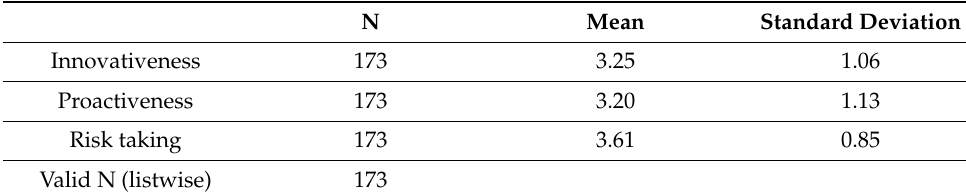
Table 6. Descriptive analysis of